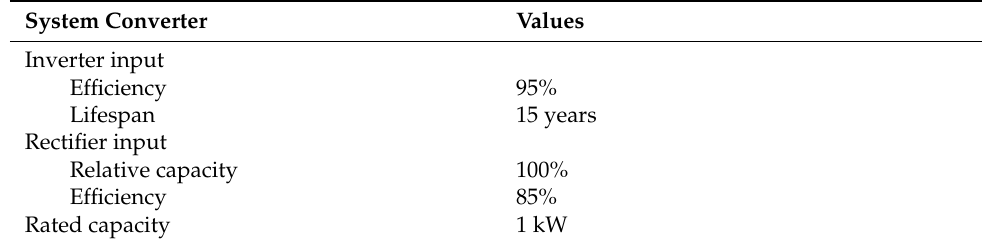
Table 12. The technical data of the selected